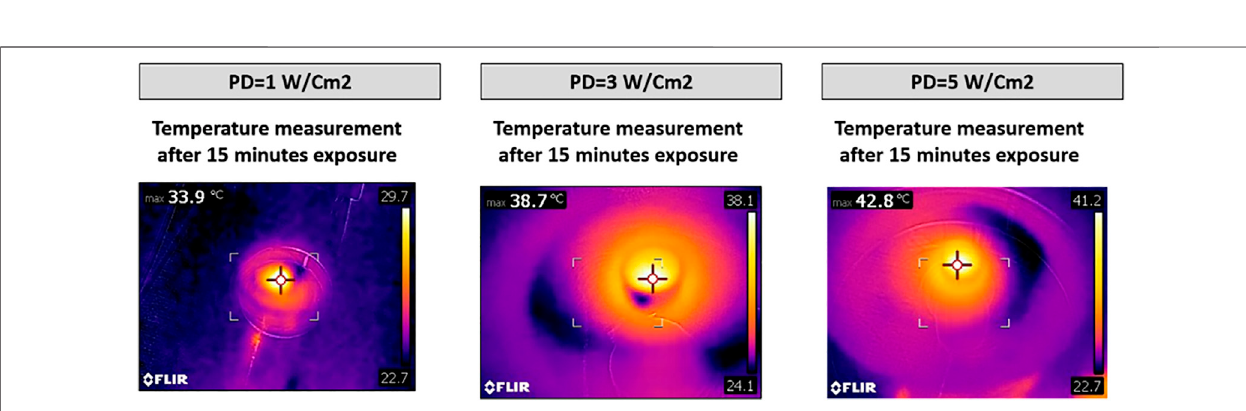
Frontiers in Nanotechnology |